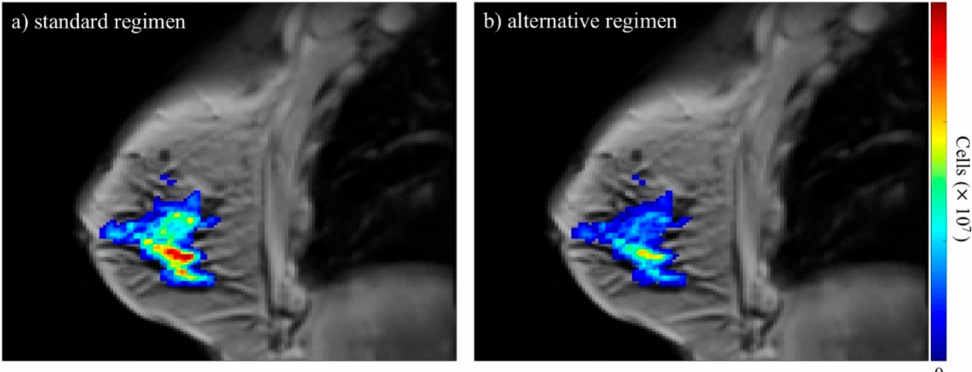
Figure 4. The figure depicts anatomical images of a central slice of the breast overlaid with the predicted total tumor cellularity in color. Panel ( a ) is the model-predicted tumor response for the standard-of-care regimen the patient actually received while panel ( b ) is the predicted response for a regimen of the same total dose with alternate dosing. This simulation indicates that the tumor burden may have been better controlled using the alternative regimen. These results were achieved by using a mathematical model [130] that is calibrated using quantitative magnetic resonance imaging (MRI) data prior to and after one cycle of therapy to define patient-specific parameter values. After calibration, the model is then simulated forward to the time of completion of therapy for the standard regimen and an alternative regimen for comparison. The standard-of-care regimen consisted of combination doxorubicin and cyclophosphamide every two weeks and the alternate regimen pictured consisted of a 1 / 14 of a dose administered daily. Studies such as these provide key motivation for the potential of applying OCT to the problem of optimizing therapeutic regimens on a patient-specific